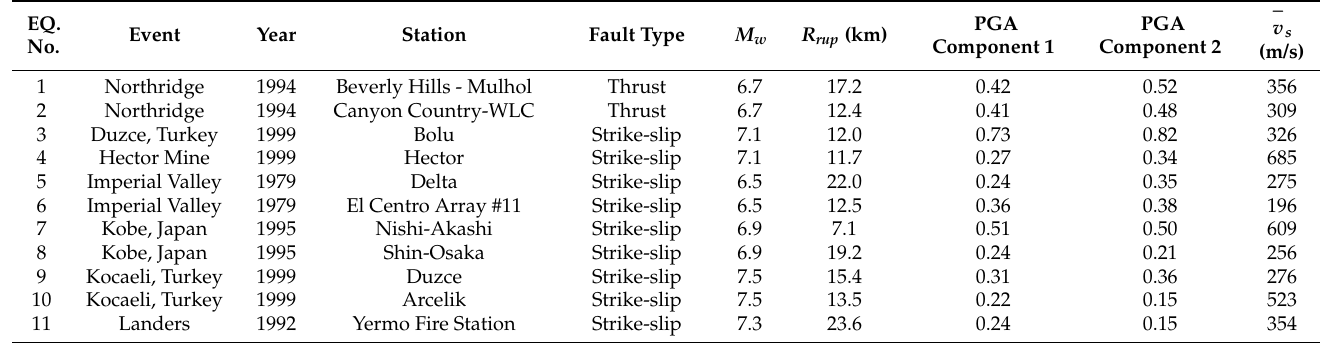
Table 1. Far-fault ground motions used for the NLRHA (Table A-4A, FEMA [31]). EQ.